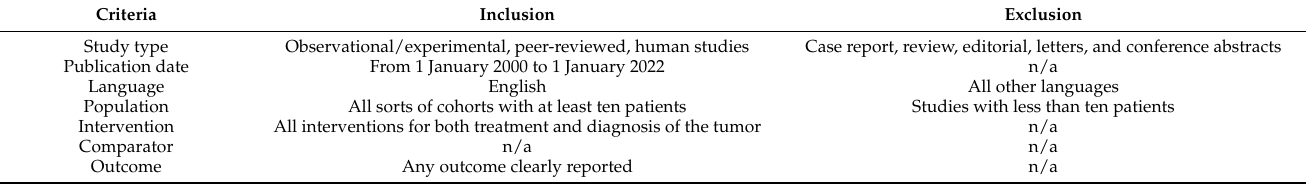
Table 1. Inclusion and exclusion criteria applied during the article selection